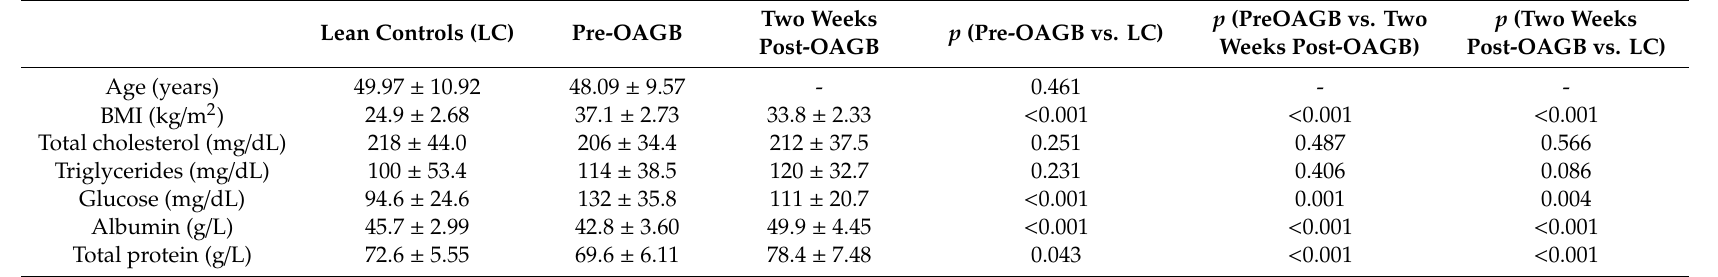
Table 1. Characteristics of lean controls and obese patients before and 2 weeks after one-anastomosis gastric bypass